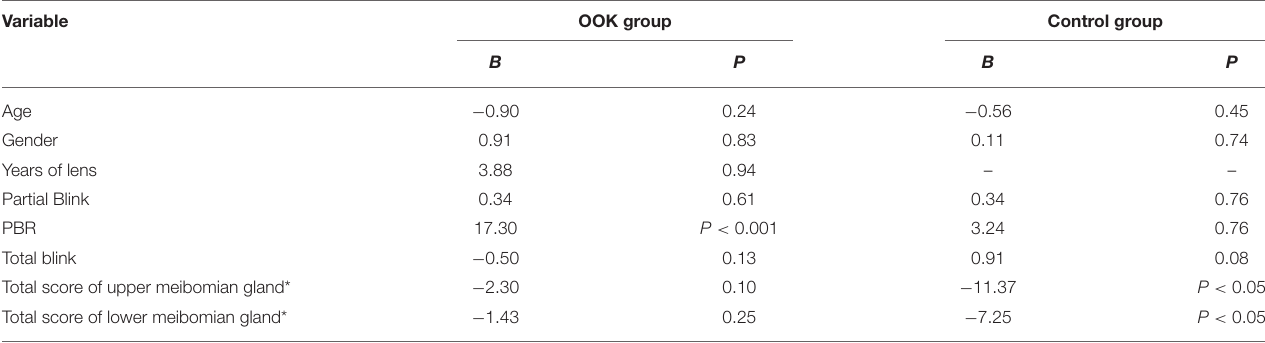
TABLE 1 | Associations of lipid layer thickness (LLT) and other parameters in generalized estimating equations models.